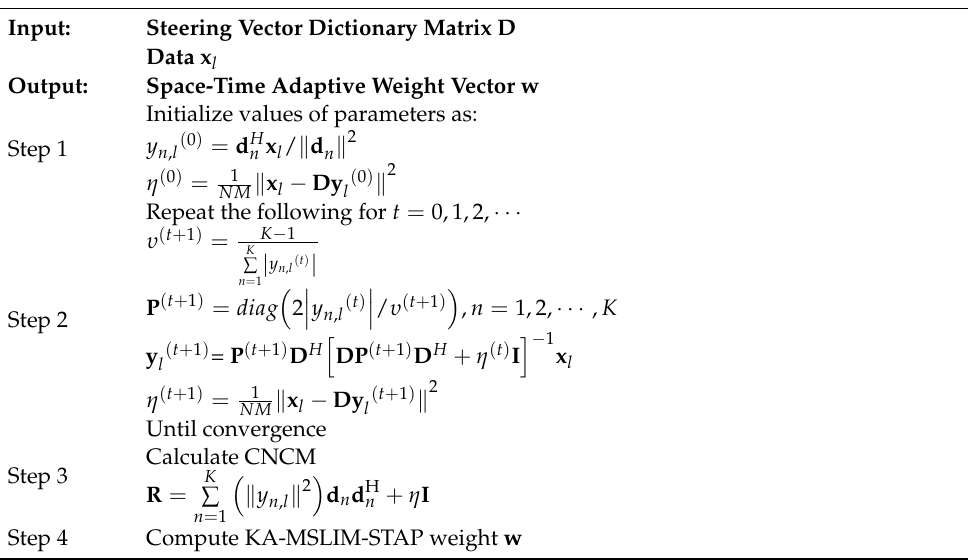
Algorithm 1: KA-MSLIM-STAP